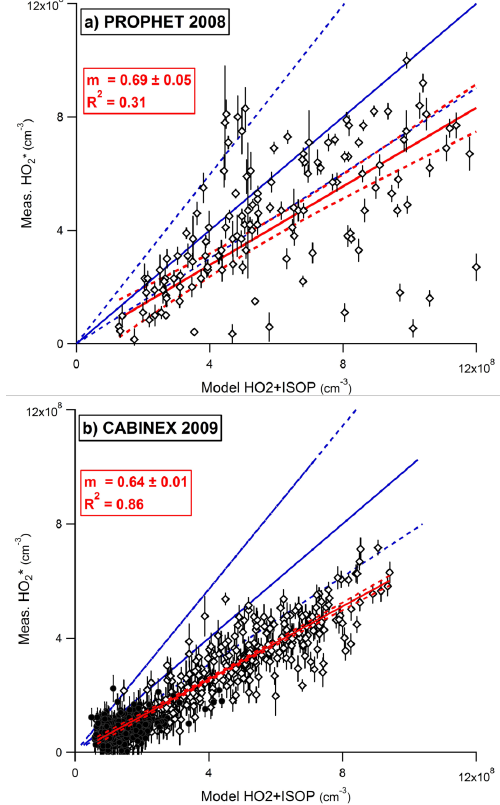
Figure 4: HO 2 * correlation plots for PROPHET 2008 (top) and CABINEX 2009 (bottom, open diamonds = daytime, filled circles = nighttime) showing 30s measurement values (sampled every 30 min) from each year. The blue lines are the 1 : 1 correlation (solid) and the model HO 2 + ISOP uncertainty (2 σ) is shown by the dashed blue lines. The solid red line is a linear regression of the data with 95% confidence limits shown as dashed red lines. Mea- surement precision for both years is approximately 1.5 × 10 7 cm − 3 .